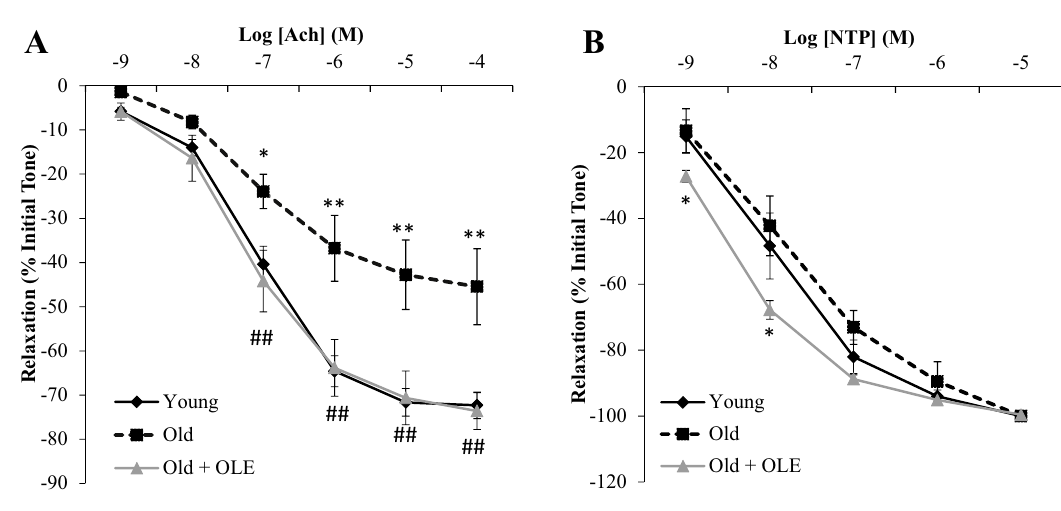
Figure 5. Effects of aging and a 21-day treatment with the OLE on the relaxation response of thoracic aortic segments to acetylcholine ( A ) and to sodium nitroprusside ( B ). Values are represented as mean ± SEM. * p < 0.05 vs. Young; ** p < 0.01 vs. Young; ## p < 0.01 vs.